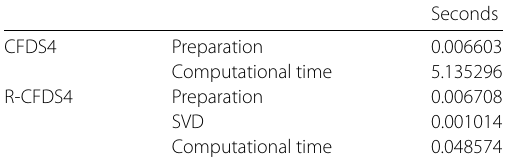
Table 3 The consuming time of two schemes for SP 1 at t = 6, with h = 0.02 π , τ = 0.01